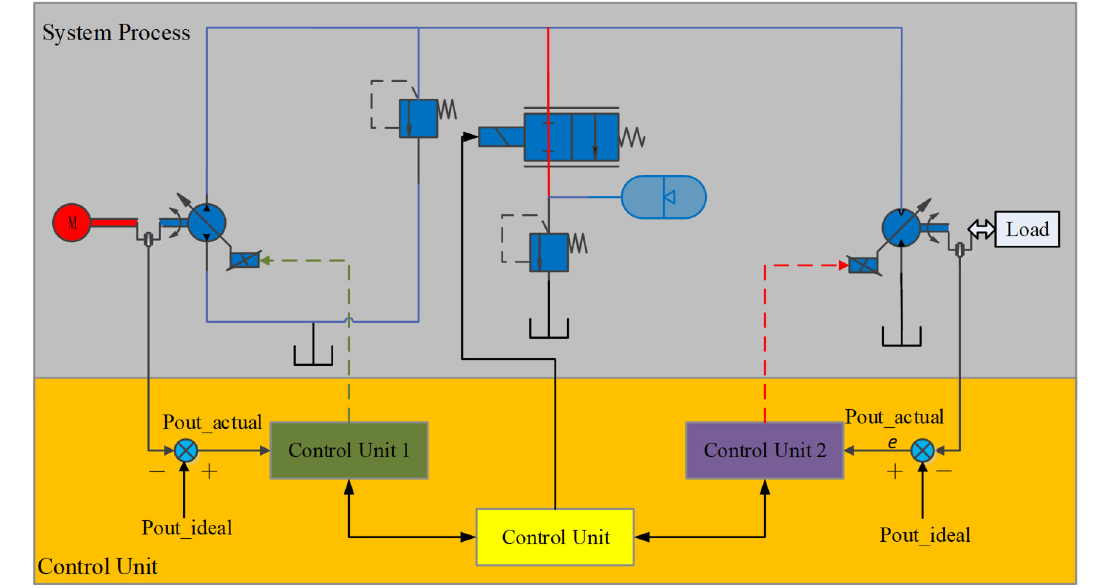
Figure 5. General control of hydraulic energy regeneration and conversion technologies [30,38,41].